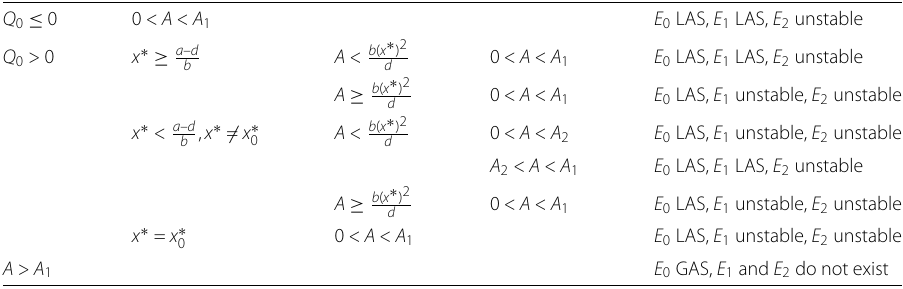
Table 4 Equilibria E i , i = 0,1,2, of system (4) with a > d Q 0 ≤